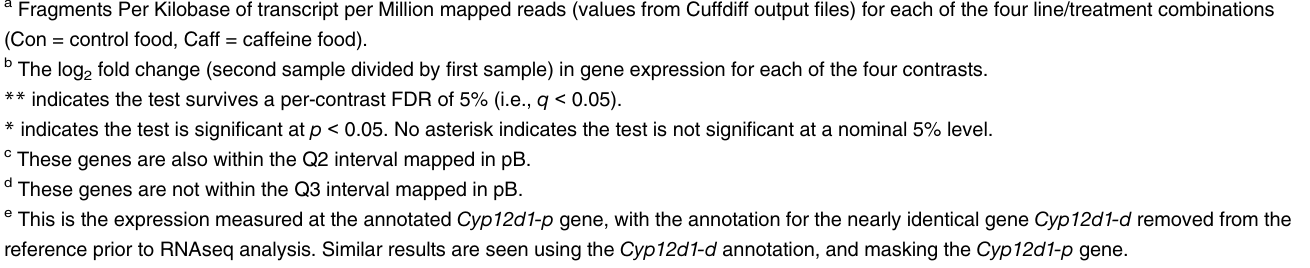
genomewide multiple-testing threshold (5% FDR) in at least one experimental contrast (Table 2). Four of these genes are annotated, but un-named genes with limited functional infor- mation in FlyBase [45]. One additional gene, Cpr49Ae , under Q3 produces a constituent of chi- tin, and is expressed at higher levels in genotypes that are more resistant to caffeine (Table 2). As a class, cuticle genes were found to be enriched among the set of genes overexpressed in a D . melanogaster strain resistant to α -amanitin, a toxin produced by a number of species of mushroom [46]. Higher expression of Cpr48Ae in caffeine resistant genotypes could plausibly be responsible for providing additional surface protection against xenobiotic exposure. None- theless, it is worth noting that Cpr48Ae is implicated only by Q3 mapped in pA, and is not pres- ent within the interval mapped in pB.